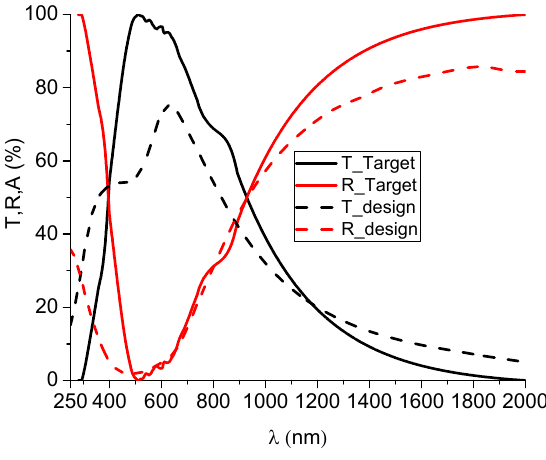
Figure 7. Spectrophotometric curves of the desired target and the optimized THR structure.